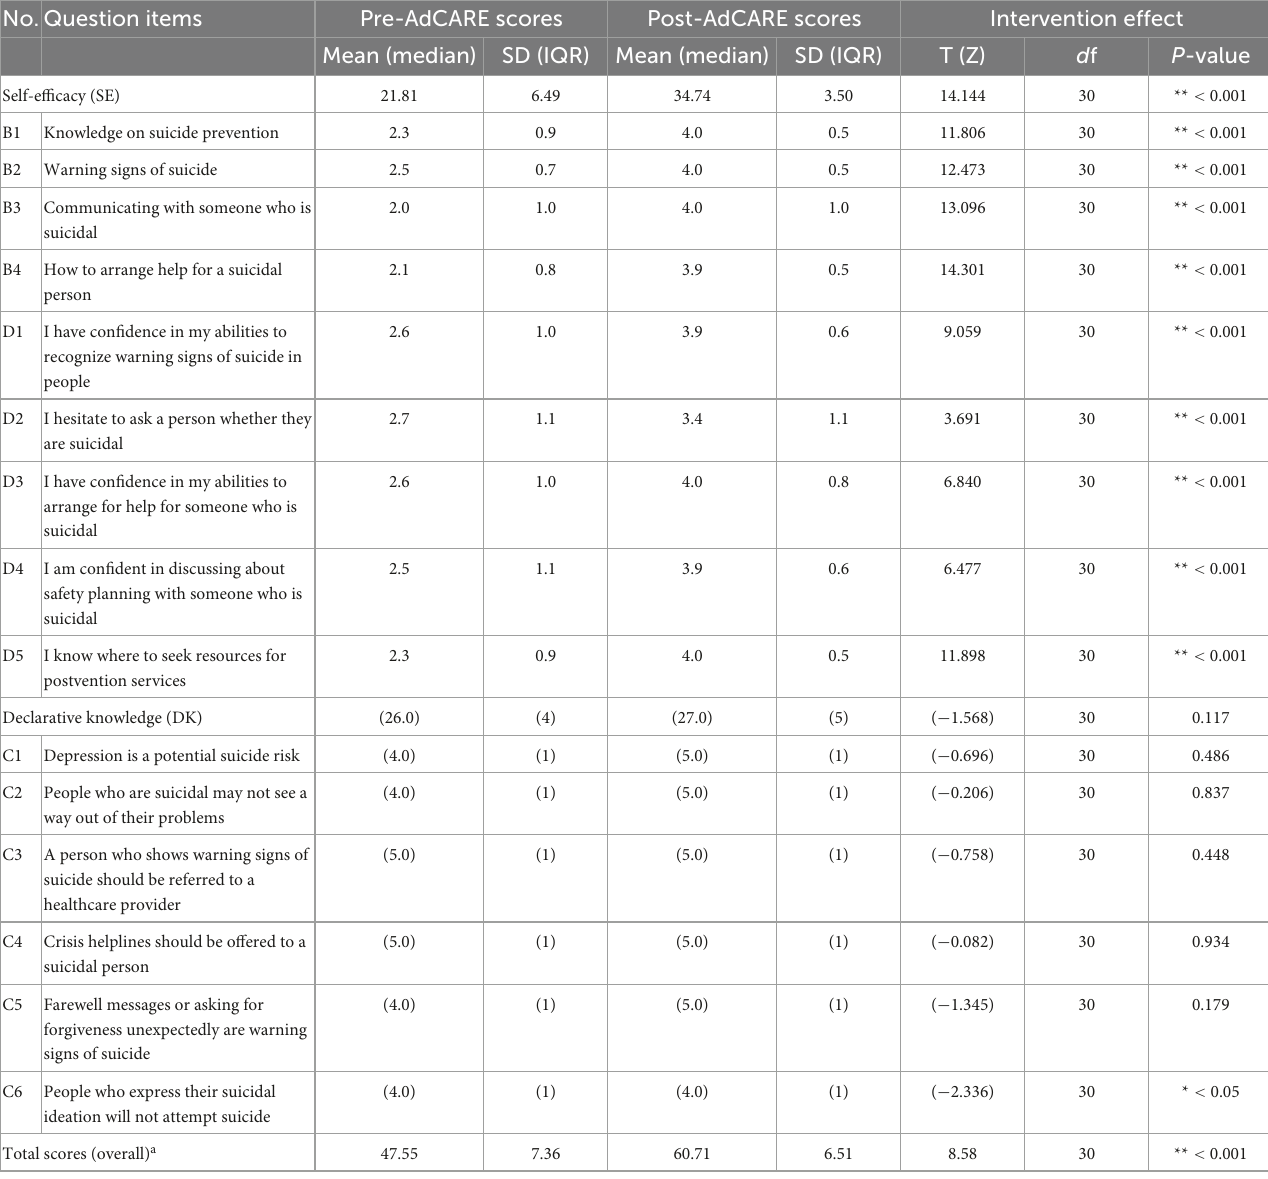
TABLE 2 Participants’ pre-and post-online AdCARE